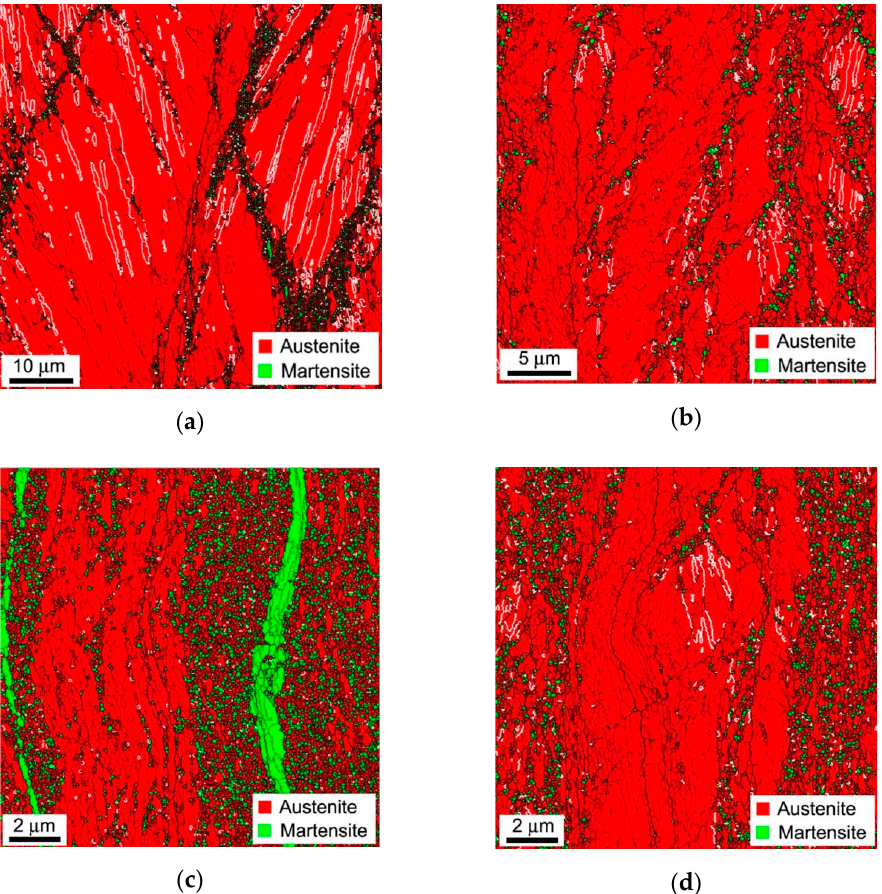
Figure 3. The austenite / martensite phase distribution in 304L ( a , c ) and 316L ( b , d ) stainless steels during rolling at 473 K to total strains of 1 ( a ), 2 ( b ) and 3 ( c , d ). High-angle, low-angle and twin boundaries are indicated by thick black, thin black and white lines, respectively.